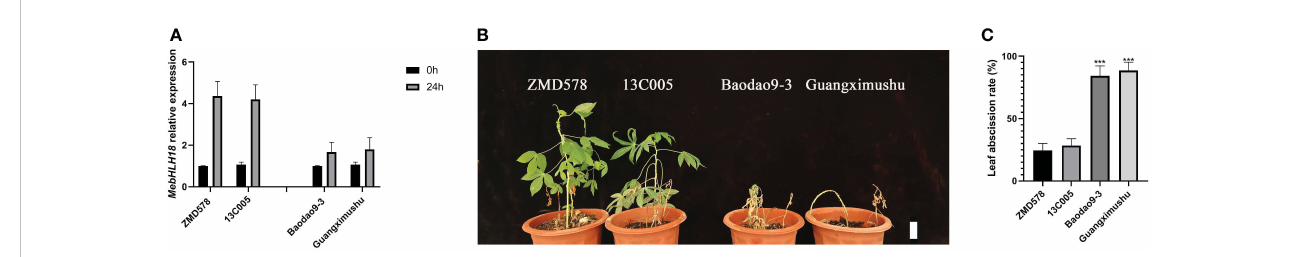
FIGURE 8 The A-T conversion of the MebHLH18 promoter region caused the change in MebHLH18 expression in different cassava germplasms. (A) The expression analysis of germplasms ZMD578 and 13C005 (with the same single nucleotide polymorphism (SNP) as SM2300-1), Baodao9-3, and Guangximushu (with the same SNP as COL514). The selected cassava germplasms were treated at 4°C for 24 hours under the same conditions. Values are represented as mean ± standard error (SE) (n=4). (B, C) Different SNP cassava germplasms, ZMD578, 13C005, Baodao9-3, and Guangximushu, had different rates of leaf abscission. All materials were treated at 4°C for 24 hours and recovered for 10 days, and then leaf abscission analysis was conducted in (C) , with mean ± standard error (n=4). The Student ’ s t-test determined statistical signi fi cance. The asterisk indicates the statistically signi fi cant difference calculated using Student ’ s t-test: ***P <